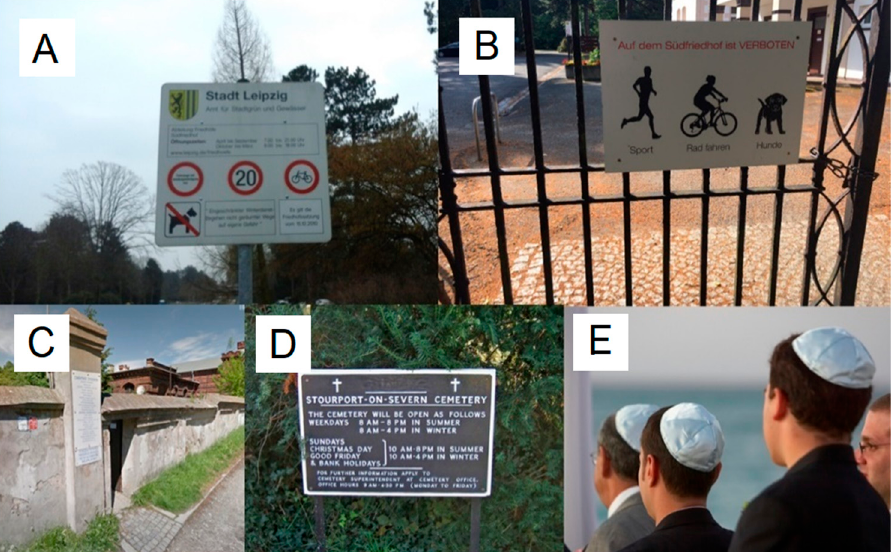
Figure 9. Barriers and restrictions to access the cemeteries in Ł ó d´z and Leipzig: Legend: ( A , B )—cemetery regulations in Südfriedhof, ( C )—side entrance to the premises of the Jewish Cemetery in Ł ó d´z, ( D )—opening hours of the Old Jewish Cemetery in Leipzig, ( E )—obligatory wearing of headgear by men at Jewish cemeteries with regard to rules and religion. Photographs by: Długo´nski A., Dushkova D.